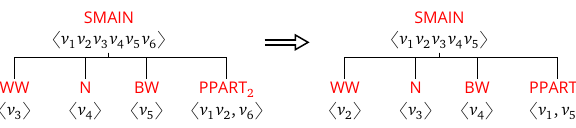
Reducing variables in a fragment extracted from the tree in Figure